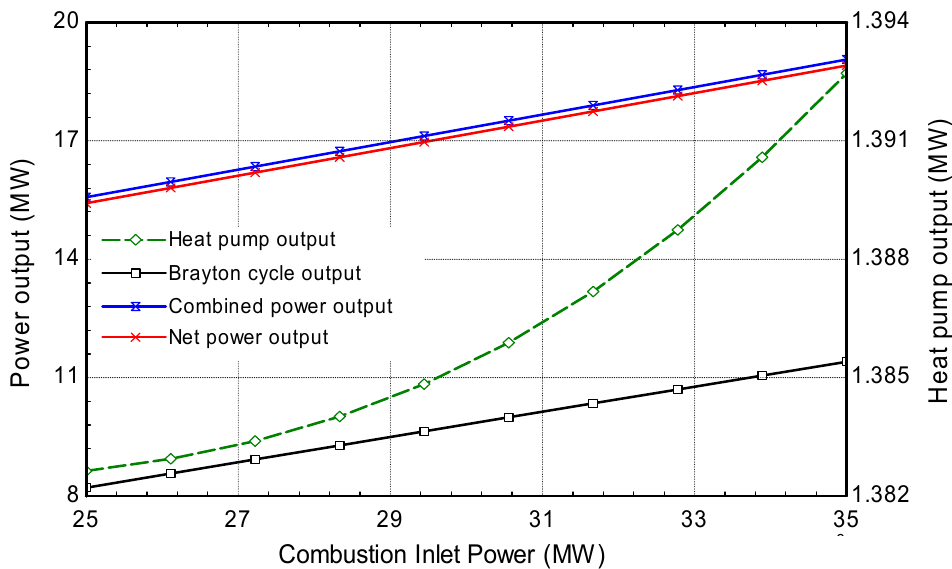
Figure 6. Impact of varying the combustion inlet energy rate on the Brayton cycle power output, combined power output, heat pump output, and the net power output of the overall system.